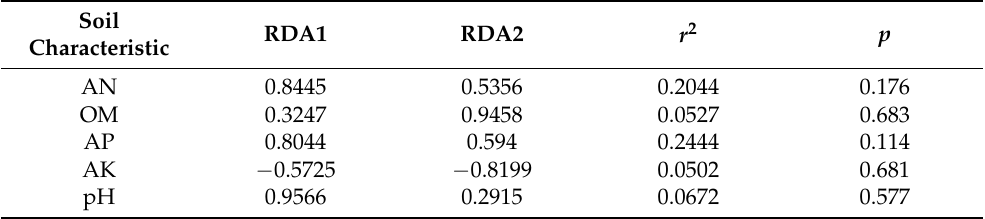
Table 3. RDA analysis results of nitrogen-fixing bacteria communities in soybean rhizosphere soil with different nitrogen application